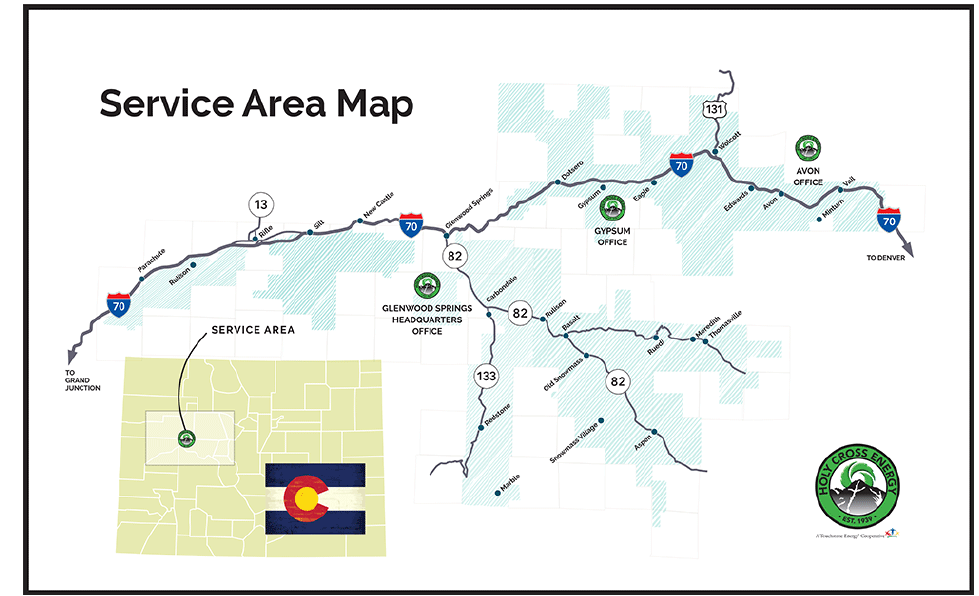
Figure 3. HCE Service